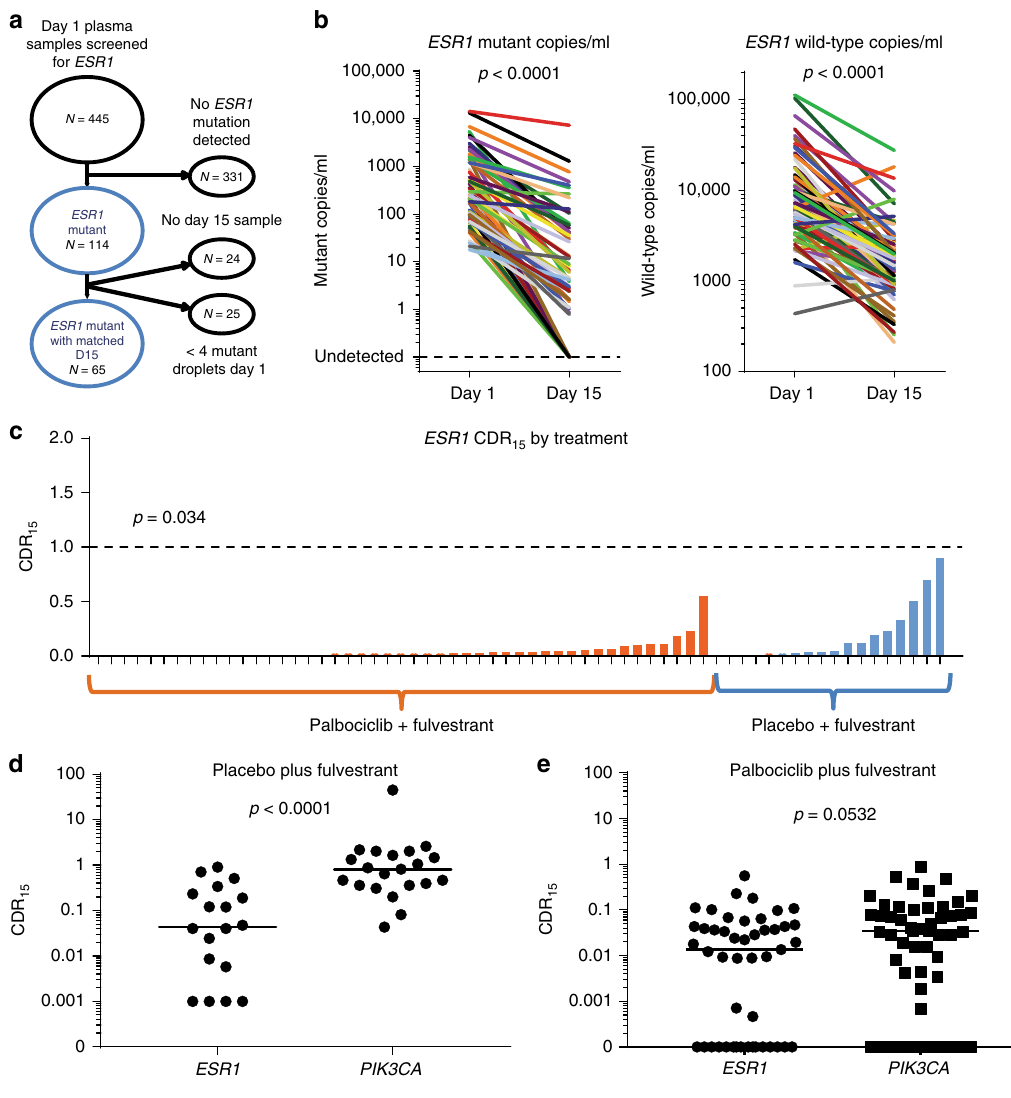
Fig. 2 ESR1 mutant sub clones have different early ctDNA dynamics to PIK3CA mutations. a CONSORT diagram for samples from PALOMA-3 used for the ESR1 mutation analysis. b Dynamics of ESR1 mutant and wild-type DNA copies/ml between day 1 and day 15 of treatment, n = 65, median ratio for mutant 0.022, median ratio for wild-type 0.21, p value Wilcoxon signed-rank test. c Mutant ESR1 CDR 15 split by treatment. p value Mann – Whitney test comparing treatments. d CDR 15 for PIK3CA mutations vs ESR1 mutations in patients randomized to fulvestrant plus placebo. p value Mann – Whitney test. Line at median. e CDR 15 for PIK3CA mutations vs ESR1 mutations in patients receiving palbociclib plus fulvestrant. p value Mann – Whitney test. Line at ESR1 mutant sub clones do not re fl ect outcome on fulvestrant .